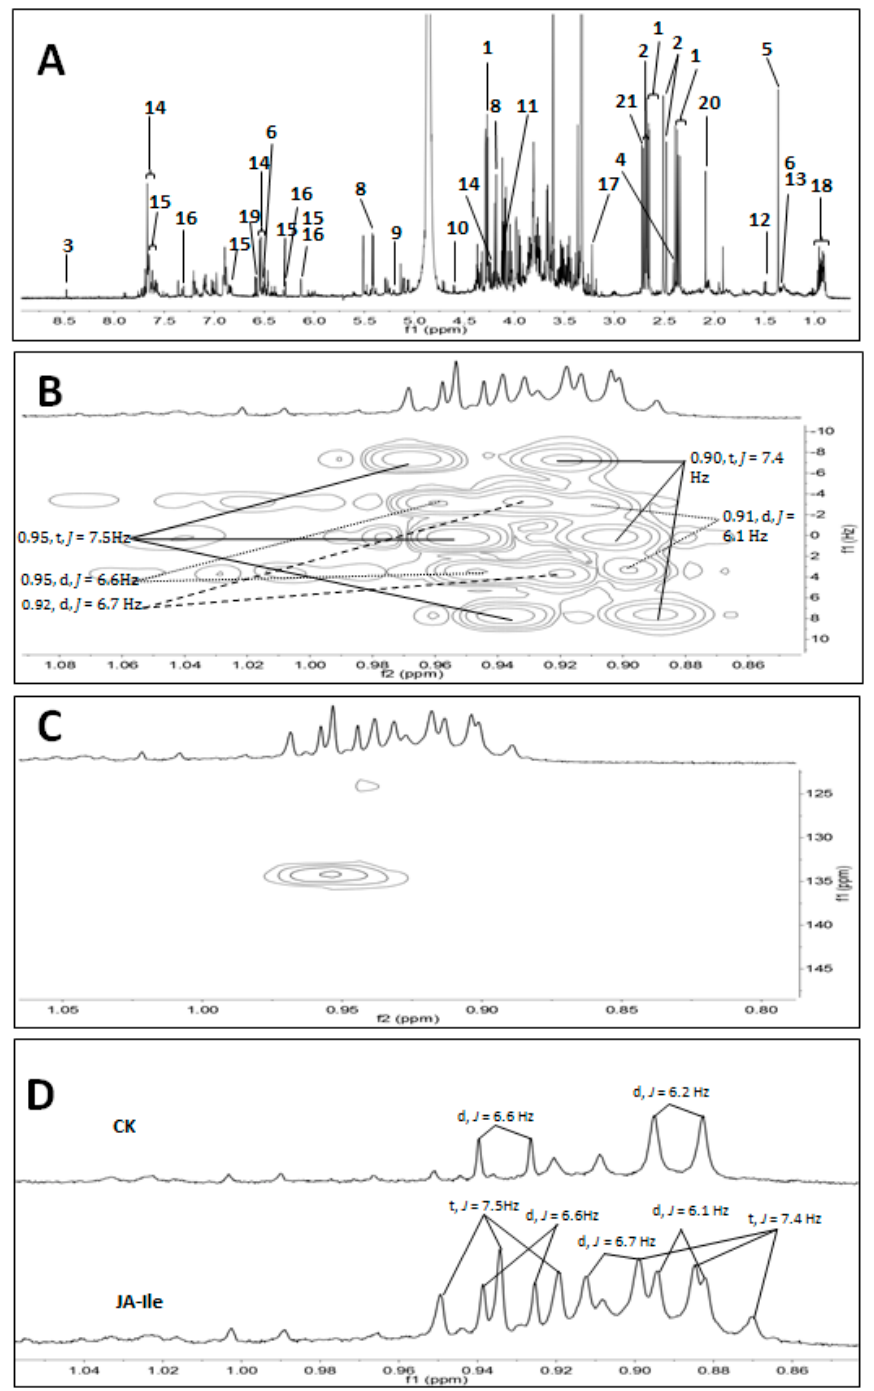
Figure 2. 1D and 2D NMR spectra of L. leucocephala leaf extracts. ( A ) Representative 1 H-NMR spectrum of L. leucocephala leaf extracts. Peaks: 1 , malic acid; 2 , citric acid; 3 , formic acid; 4 , succinic acid; 5 , RC(OH)CH 3 -COOH; 6 , lactic acid; 7 , fumaric acid; 8 , sucrose; 9 , α -glucose; 10 , β -glucose; 11 , fructose; 12 , alanine; 13 , threonine; 14 , mimosine; 15 , quercetin; 16 , quercetin-3- O - α -rhamnoside; 17 , choline; 18 , steroids; 19 , 3,4-dihydroxypyridine; 20 , unidentified; 21 , unidentified; ( B ) J values were determined in the 2-dimensional J -resolved NMR spectroscopy of JA-Ile treated plants; ( C ) HMBC correlation between methyl signals and olefinic carbon at δ c 134.2; ( D ) A set of methyl signals at 0.85-1.05 ppm in JA-Ile elicited L. leucocephala leaf extracts was compared to control (CK).